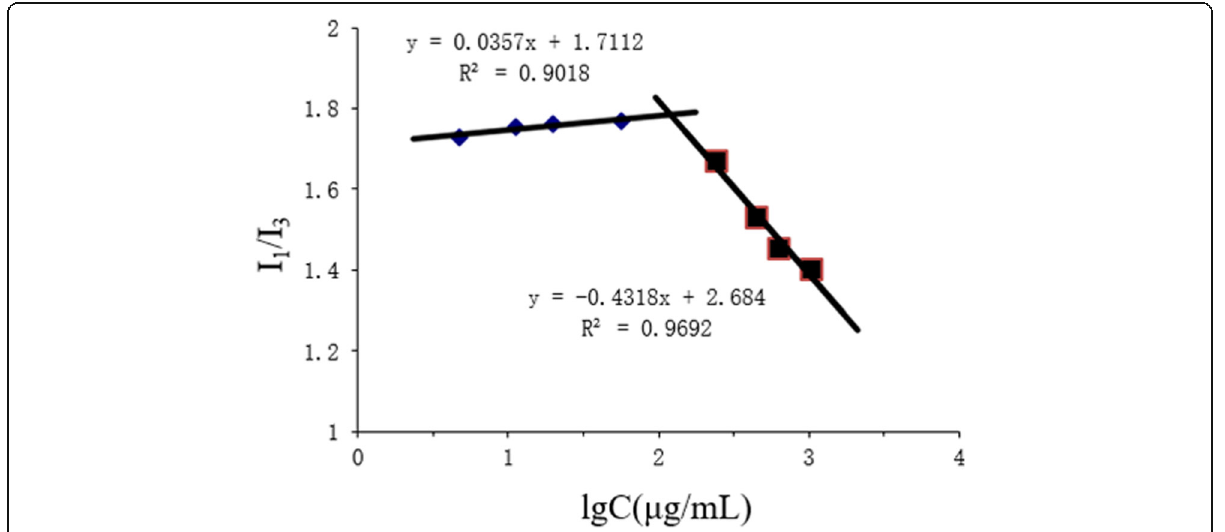
Fig. 1 Variation of fluorescence intensity ratio ( I 1 / I 3 ) versus logarithm concentration of